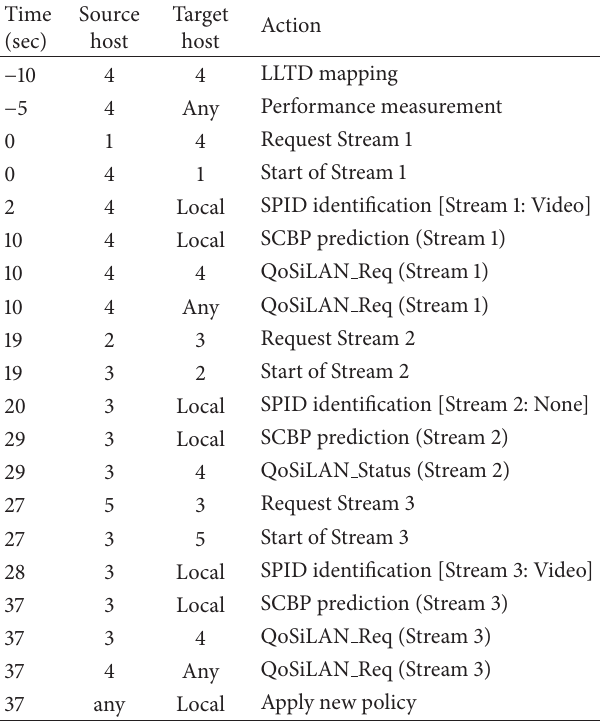
Table 2: Evaluation action